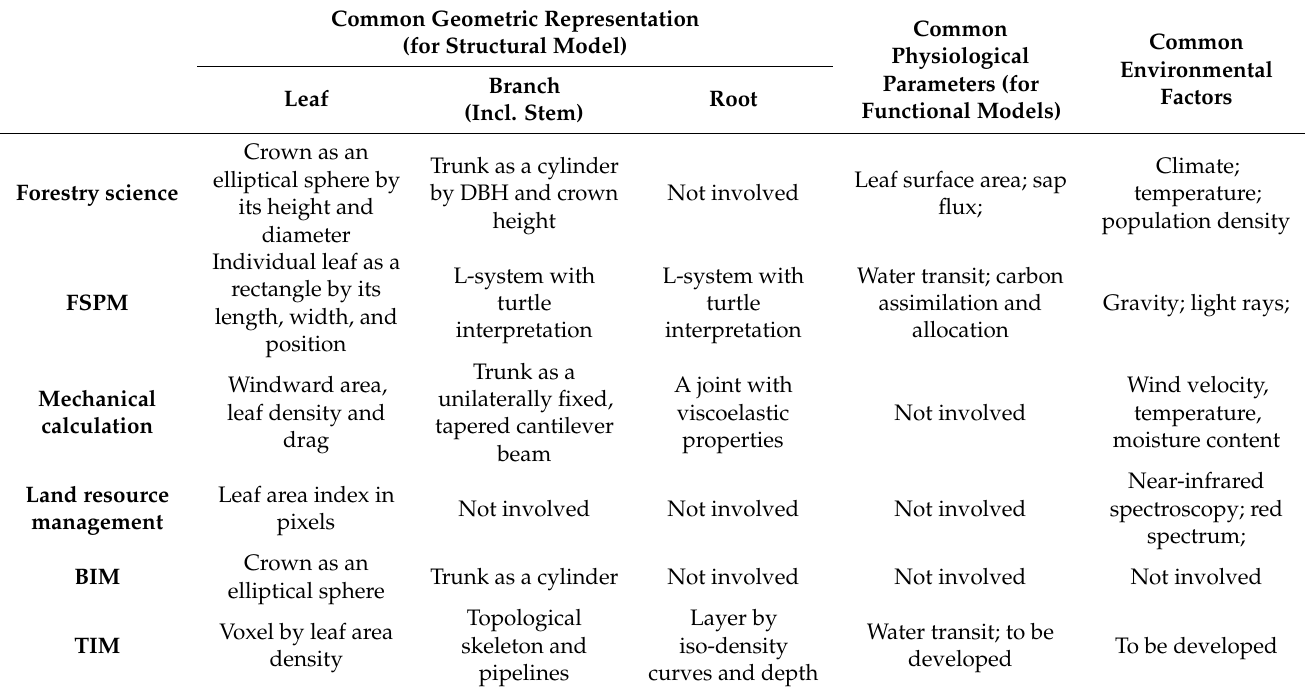
Table 2. Comparison between common tree models used in multiple fields and